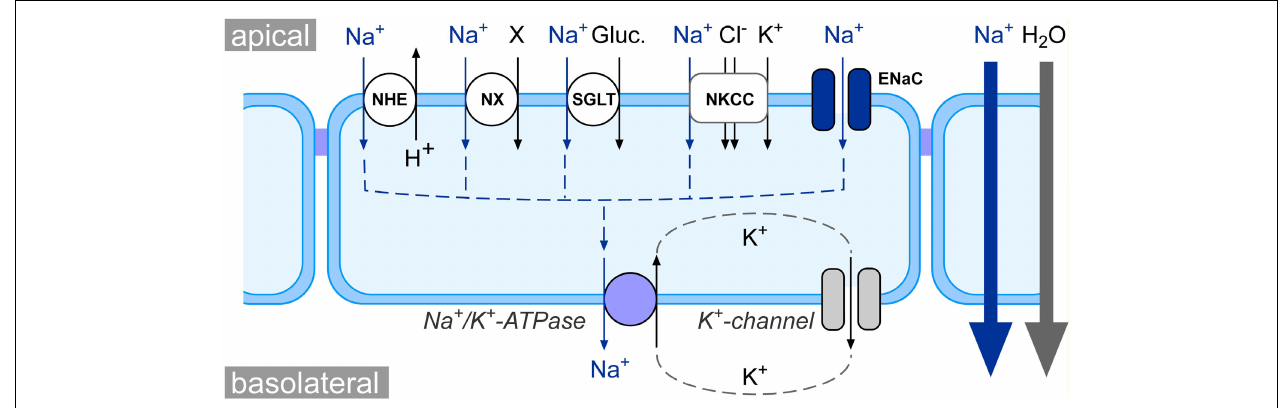
FIGURE 1 | Schematic model of epithelial Na + transport physiology. At the apical side of epithelia, Na + enters the cell either via Na + coupled transporters, such as the Na + /H + exchanger (NHE), Na + -coupled amino acid or phosphate symporters (NX), Na + /glucose symporters (SGLT), and Na + /K + /2Cl − cotransporters (NKCC), or via Na + selective ion channels such as the epithelial Na + channel (ENaC).The electrochemical gradient for apical Na +